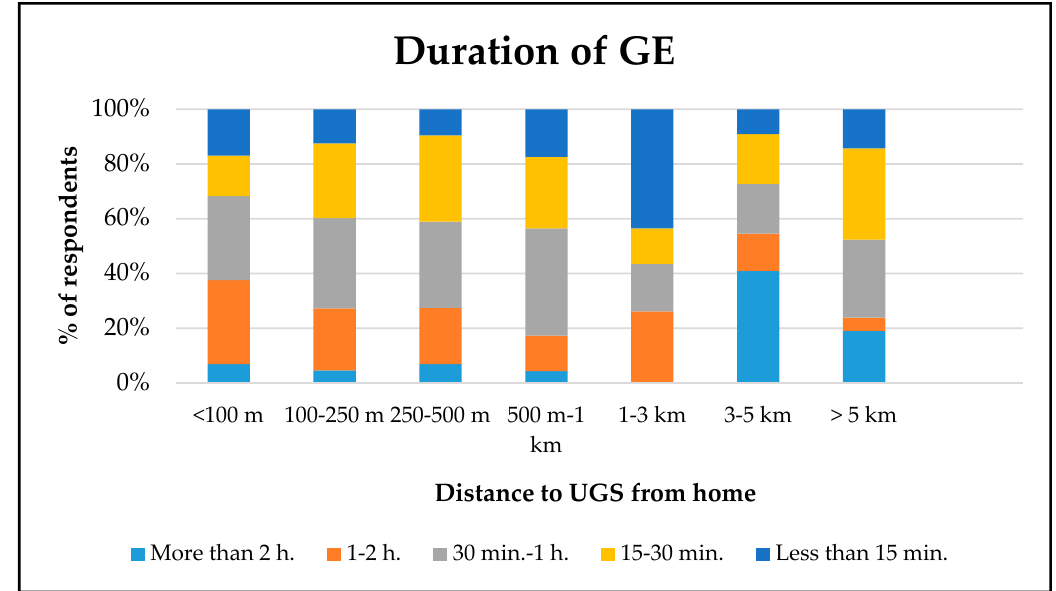
Figure 3. Distance to UGS versus duration of GE, in percent of the respondents. GE: Green exercise, UGS: urban green space.